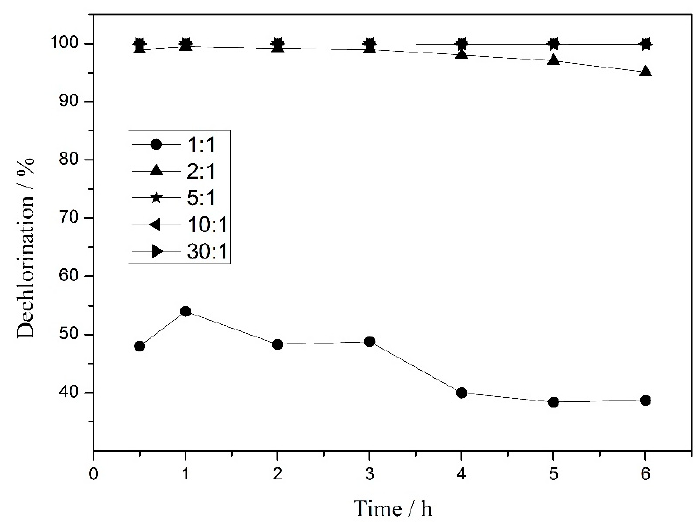
Figure 5. Dechlorination of 4-CP during HDC reaction in a Pd/CNT-Ni foam micro reactor under different FA/substrate molar ratios. Reaction conditions: residence time (3 min), Pd loading (0.5 wt.%), 4-chlorophenol concentration (1 mmol/L).